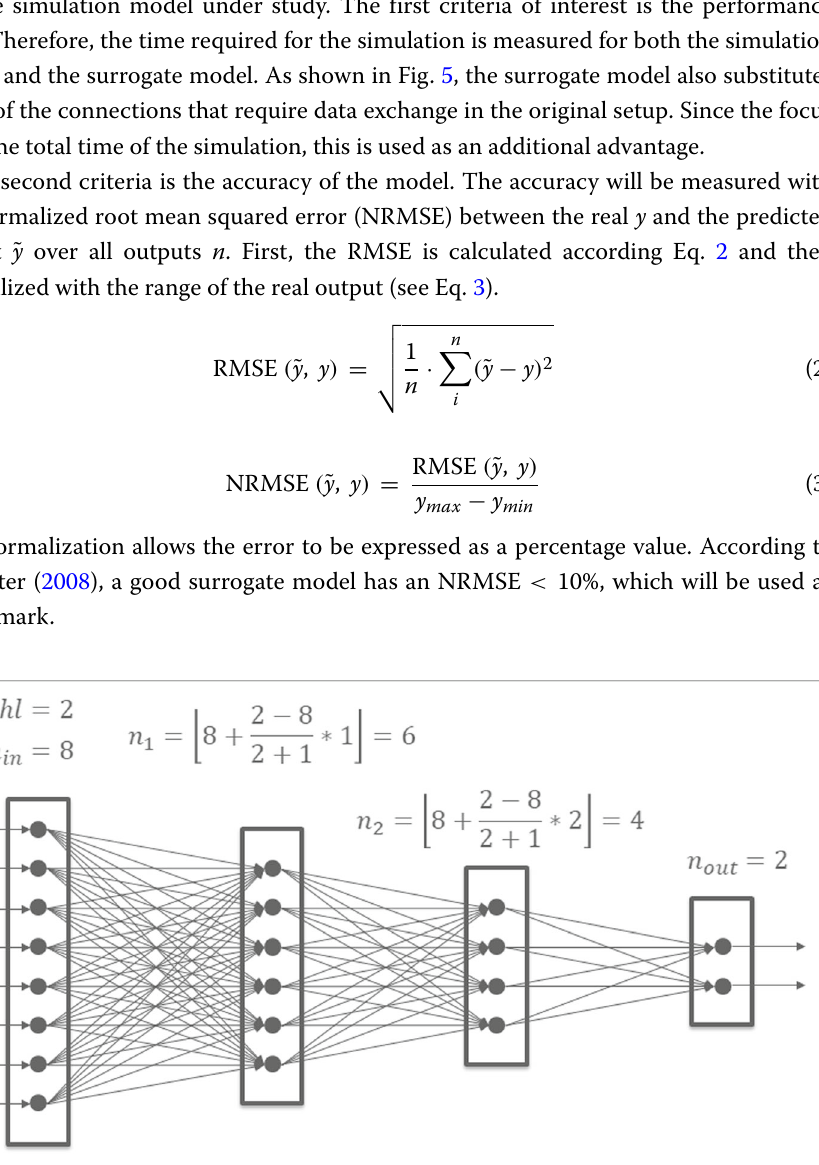
Fig. 6 Example ANN architecture with input size n in = 8, output size n out = 2 and two hidden layers. The hidden layer sizes are calculated using formular